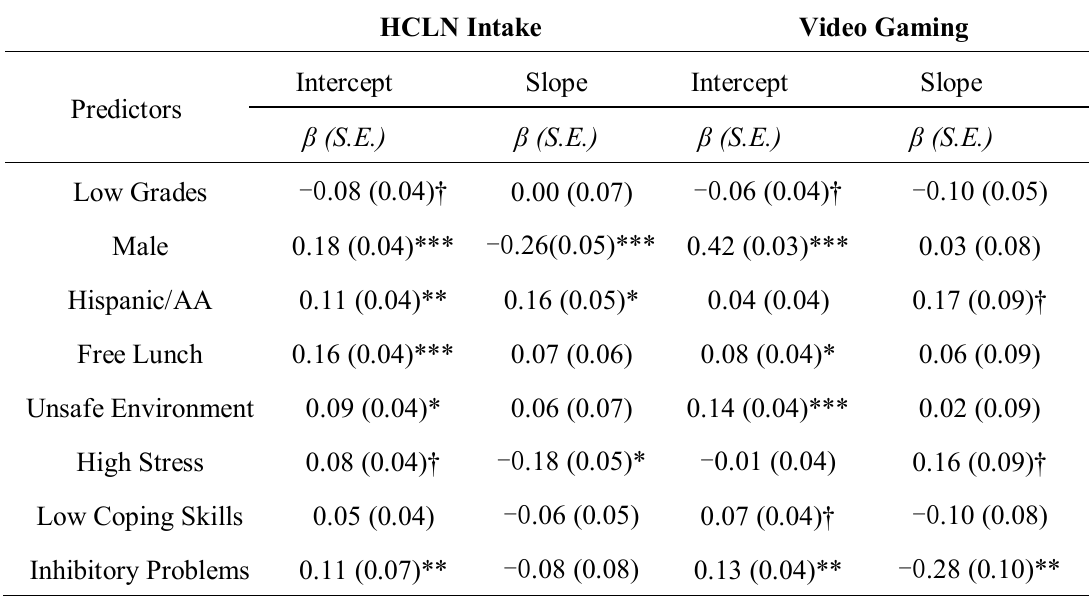
Table 3. Predictors of growth in HCLN intake and video